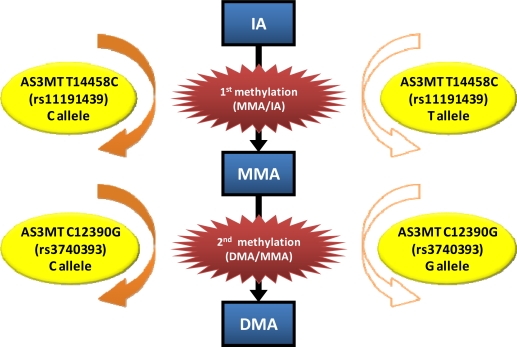
Suspected universal AS3MT genotype-dependent methylation of arsenic. C carrier of AS3MT 14458 (rs11191439) may have higher first methylation capacity than the T carrier, while C carrier of AS3MT 12390 (rs3740393) may have higher second methylation capacity than the G carrier.